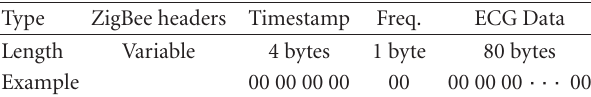
Table 1: ZigBee ECG